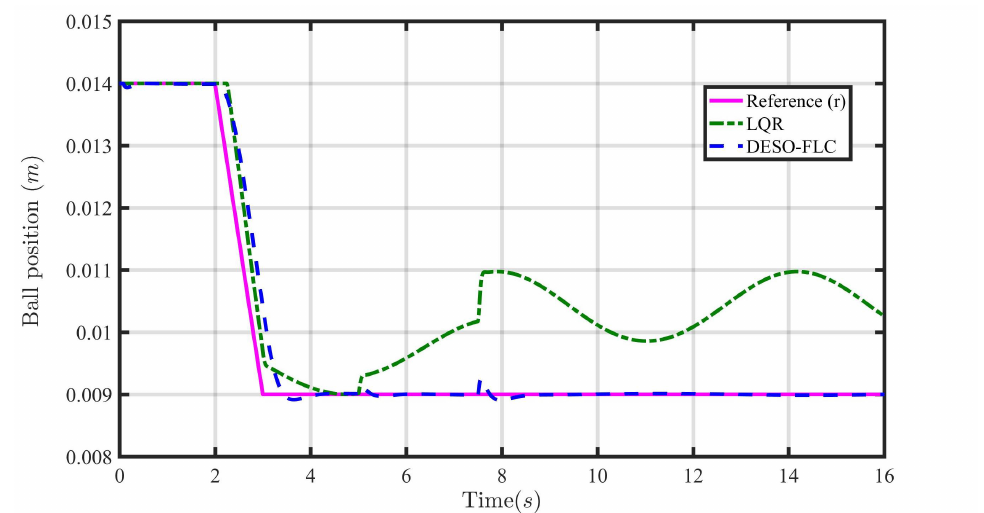
Figure 13. Response of the steel ball position ( x 1 ) in the presence of payload disturbances and parametric uncertainties.